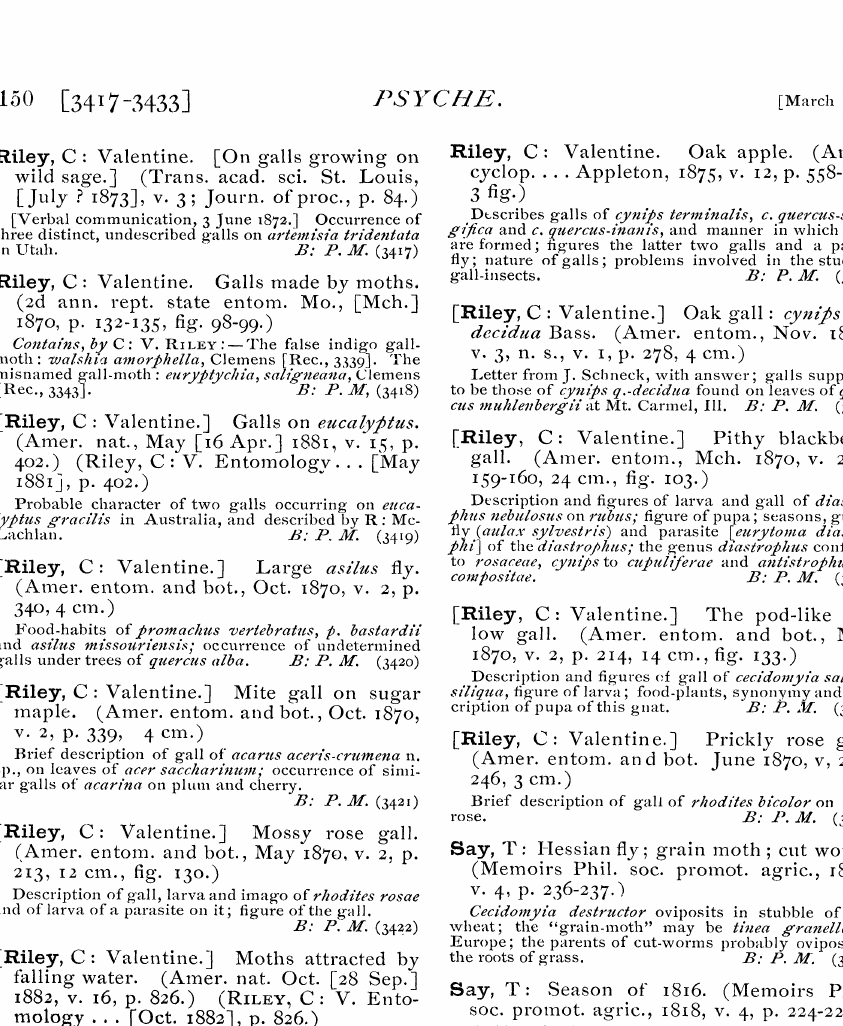
Synoptic table of species of the genus col Cont. frotn o_p. eft., Mar.